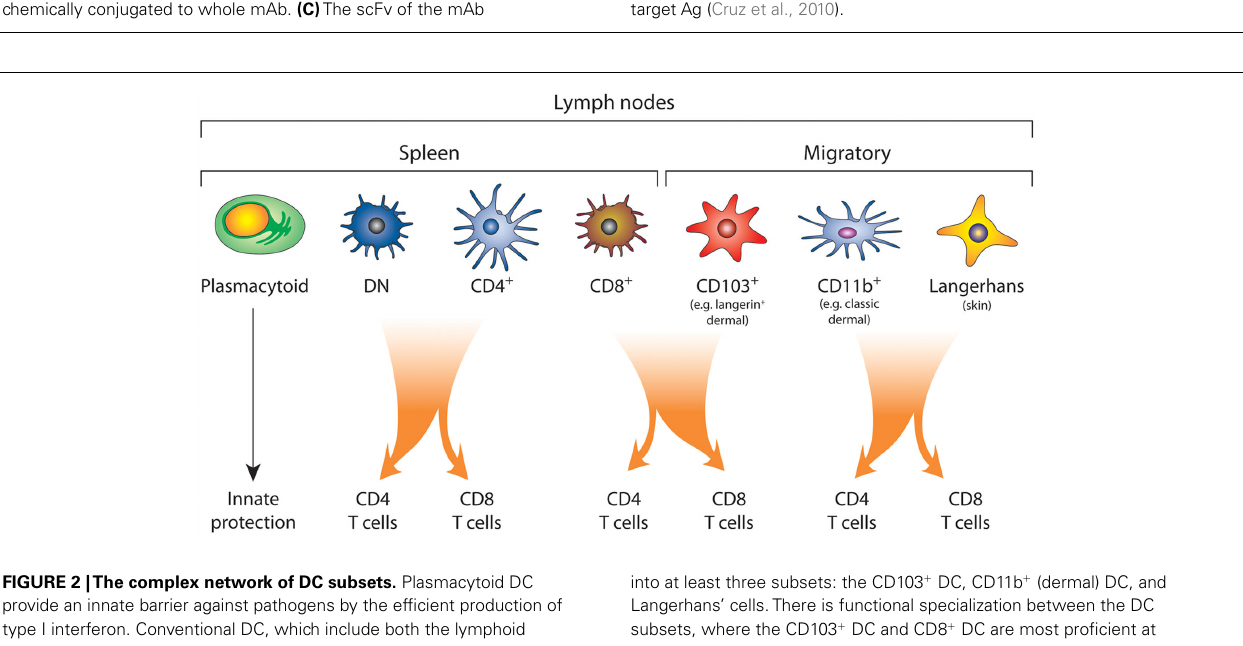
FIGURE 2 |The complex network of DC subsets. Plasmacytoid DC provide an innate barrier against pathogens by the efficient production of type I interferon. Conventional DC, which include both the lymphoid tissue-resident DC and migratory DC, drive the adaptive immune response. In the mouse spleen, the lymphoid tissue-resident DC are divided into those that express of CD8 α (CD8 + ), CD4 (CD4 + ), or those that express neither CD4 or CD8 α , the double negative (DN) DC subset.The lymph nodes also contain migratory DC, which can be further segregated